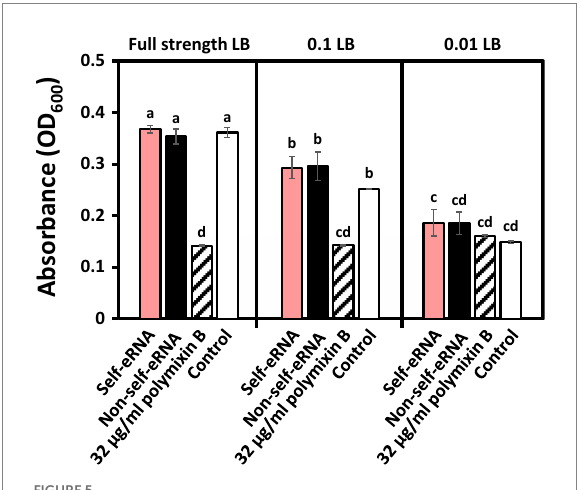
FIGURE 5 Evaluation of the direct effect of self-eRNA treatment on the growth of X. axonopodis pv. vesicatoria (Xav). Growth of XaV amended with 100 ng/ μ l self-eRNA (pepper) and non-self-eRNA ( P. syringae pv. tomato ) was monitored in full-strength LB (left panel), 10-fold diluted (0.1) LB (middle panel), and 100-fold diluted (0.01) LB (right panel) for 45 h. Polymyxin B (32 μg/ml) was used as a positive control. Data represent mean ± SEM ( n = 3). Different letters indicate statistically significant differences between control and other treatments ( p = 0.05; LSD